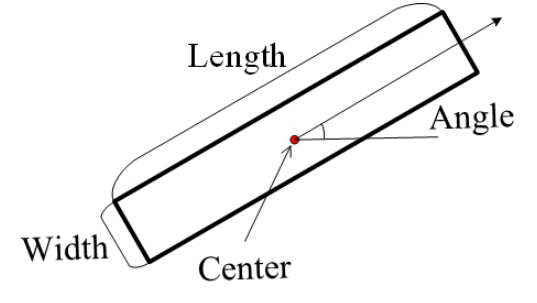
Figure 6. Rectangular description of the line-support